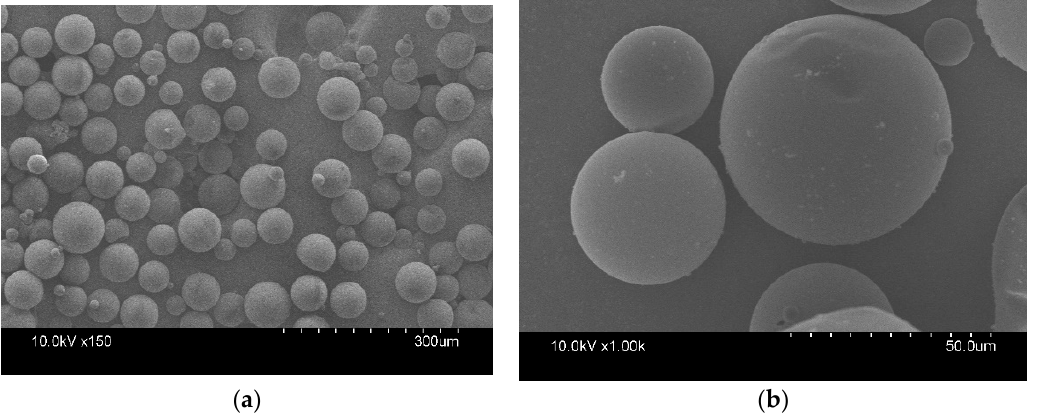
Figure 4. SEM images of the the phase change microcapsules (microPCMs): ( a ) ×150; ( b ) ×1000.